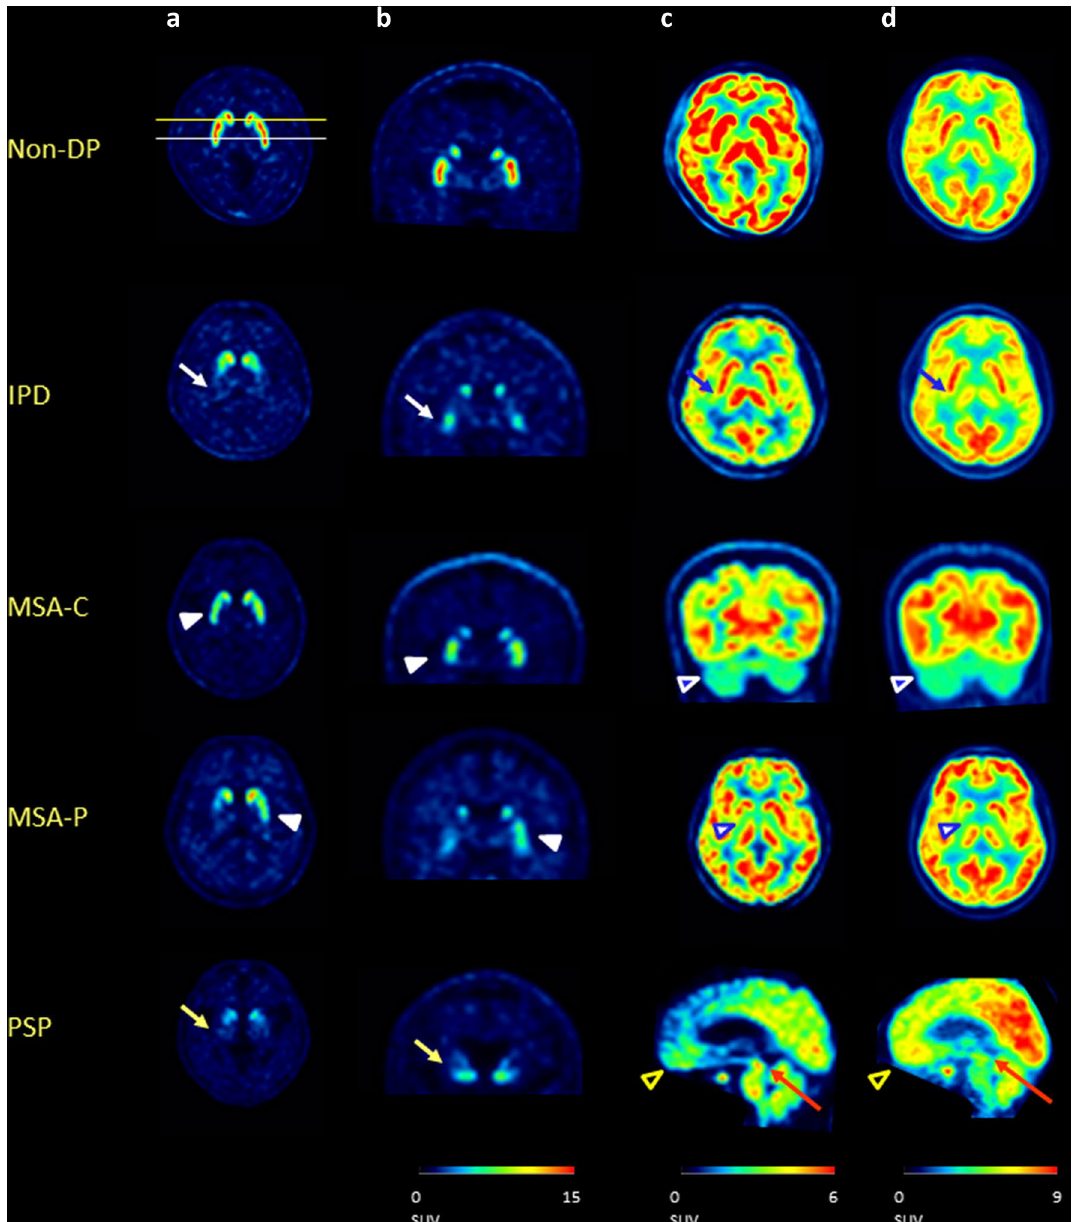
Figure 1. Examples of axial ( a ) and coronal slice ( b ) of delayed phase 18 F-FP-CIT PET, early phase 18 F-FP- CIT PET ( c ), and 18 F-FDG PET ( d ) of patients with non-degenerative parkinsonism (1st row), IPD (2nd row), MSA-C (3rd row), MSA-P (4th row), and PSP (5th row). The patient with IPD (2nd row) showed decreased DAT binding of the bilateral dorsal posterior putamen, with relative sparing of the ventral putamen (white arrow) on delayed phase 18 F-FP-CIT PET, and normal striatal metabolism or hypermetabolism in the bilateral dorsolateral putamen on early phase 18 F-FP-CIT PET and 18 F-FDG -PET (blue arrow). The patient with MSA-C and MSA-P (3rd and 4th rows), shows DAT loss not only in the posterior putamen, but also in the ventral putamen (white arrow head) on delayed phase 18 F-FP-CIT PET. On early phase 18 F-FP-CIT PET and 18 F- FDG -PET, MSA showed hypometabolism in the cerebellar cortex (blue arrow head with white outline) and/ or hypometabolism in the basal ganglia (blue arrow head with white outline. The patient with PSP showed extensive DAT loss on both the putamen and caudate nuclei on delayed phase 18 F-FP-CIT PET (yellow arrow), which was characterized by hypometabolism in the medial frontal cortices (black arrow head with yellow outline) and midbrain (red arrow) on early phase 18 F-FP-CIT PET and 18 F-FDG PET. All PET images were processed using PMOD 4.0 (PMOD Technologies Ltd., Zurich,